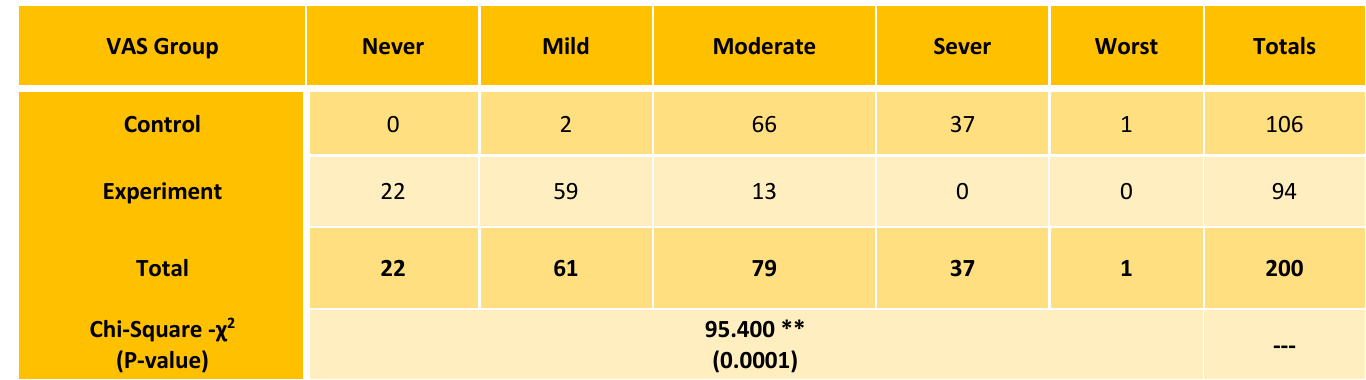
Table 8. Distribution of sample according to VAS/E&C.